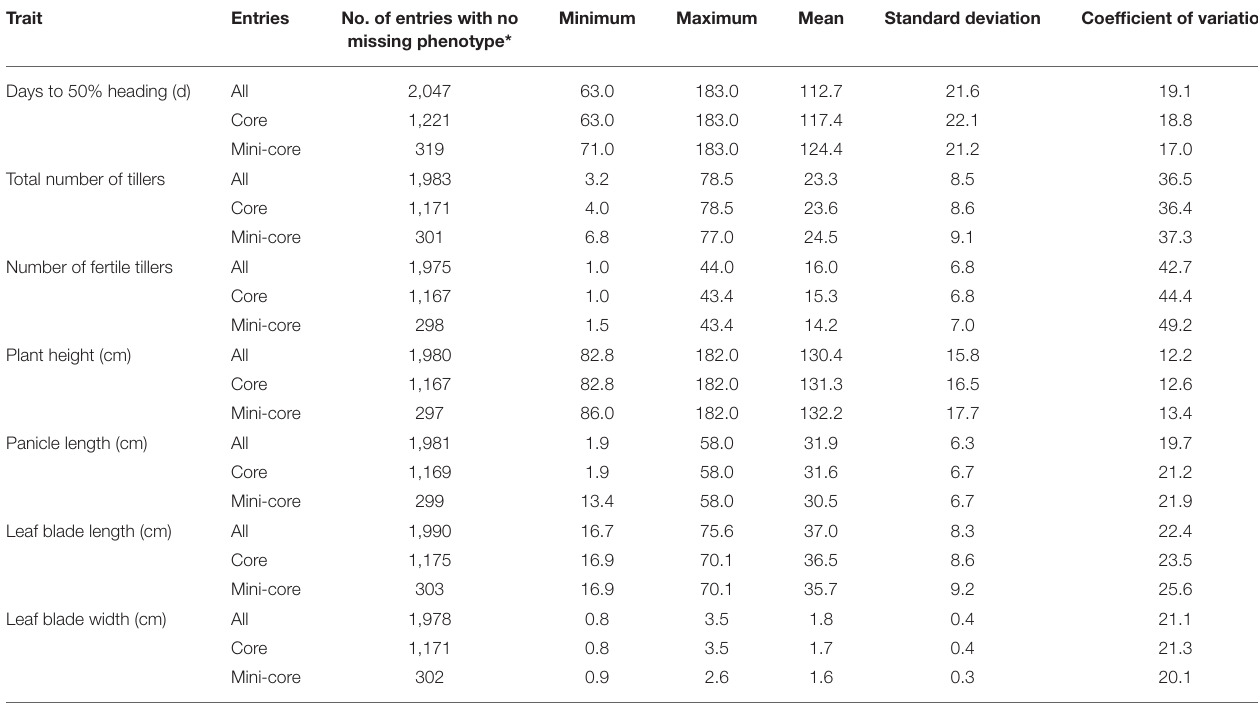
TABLE 5 | Summary of seven phenotypic descriptors for the core and mini-core sets as compared to the whole O. glaberrima collection based on unreplicated data evaluation at the AfricaRice experimental station in Cotonou, Benin. Trait Entries Maximum Mean Standard deviation Coefficient of